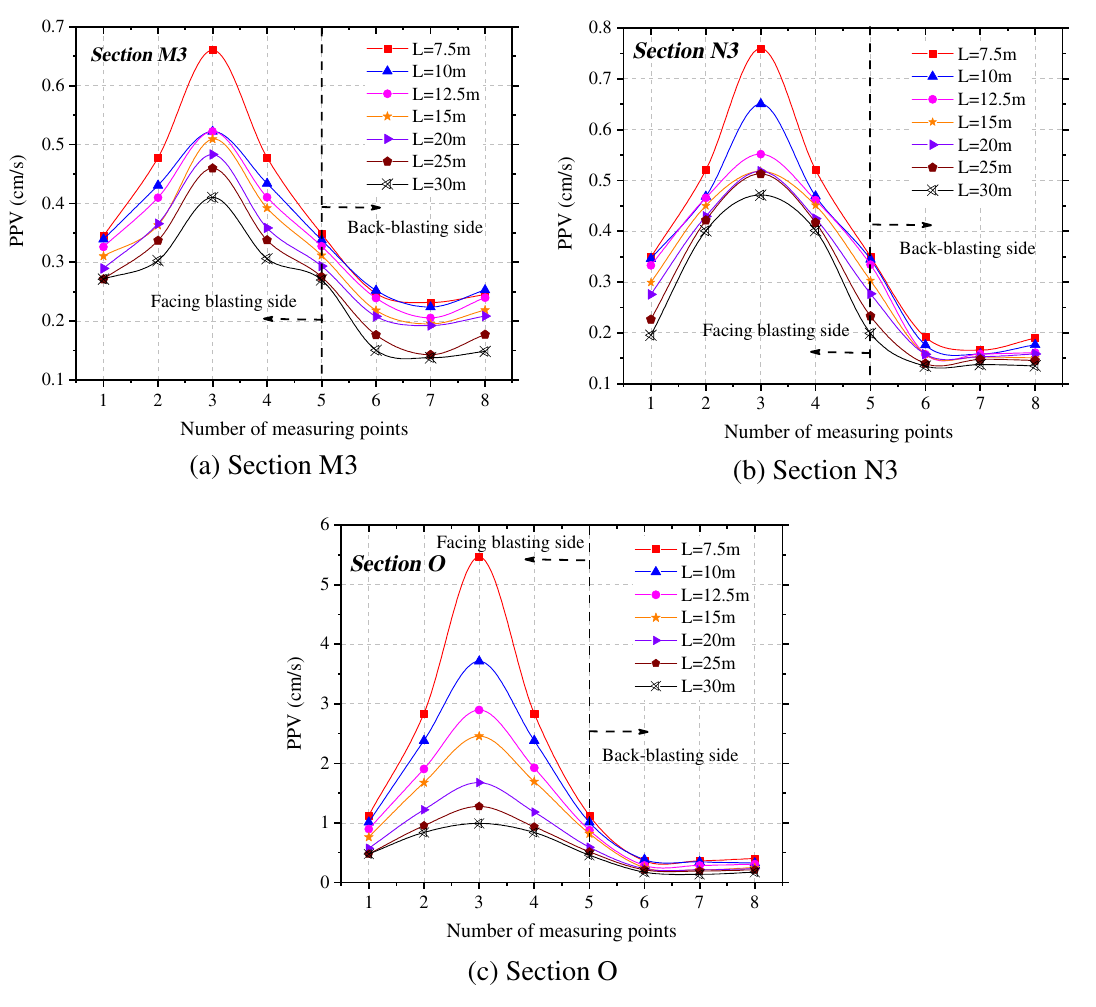
Figure 7. PPV of rock surrounding the adjacent tunnel under different spacings between tunnels.